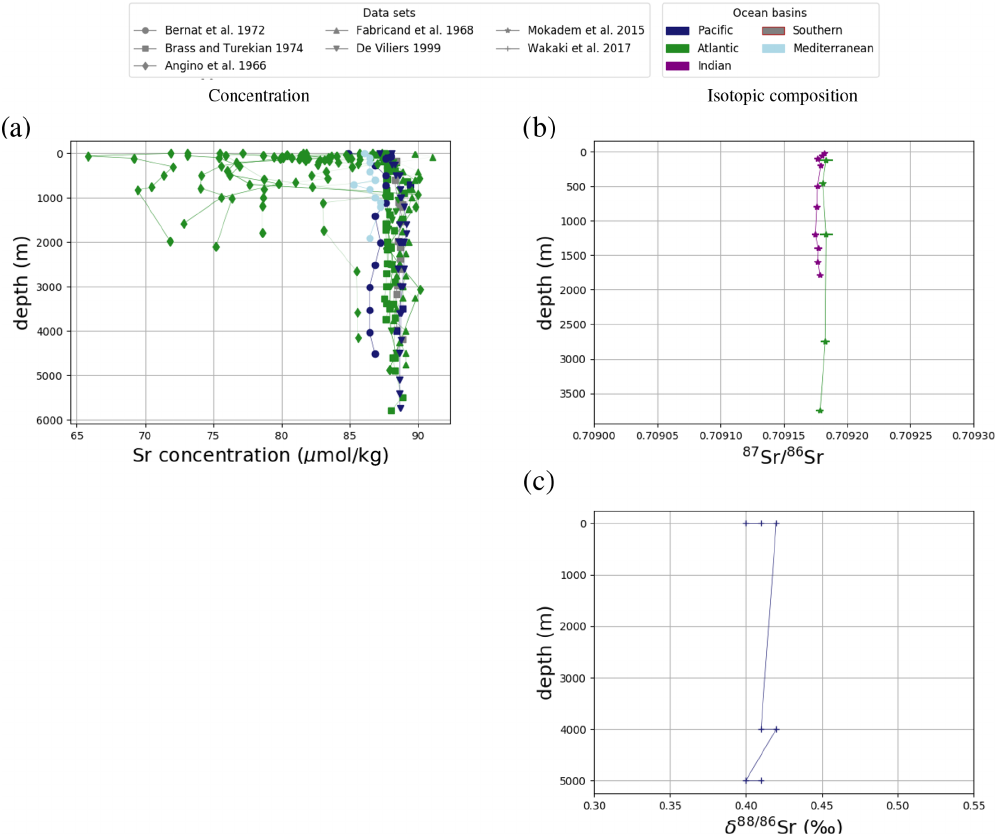
Figure F1. Measured Sr ocean profiles. Composites of all available profiles of measured concentrations (a) and isotopic compositions (b) are shown. Data are taken from Angino et al. (1966), Fabricand et al. (1967), Bernat et al. (1972), Brass and Turekian (1974), De Villiers (1999), Mokadem et al. (2015), and Wakaki et al. (2017). Sr concentrations are normalized to a salinity of